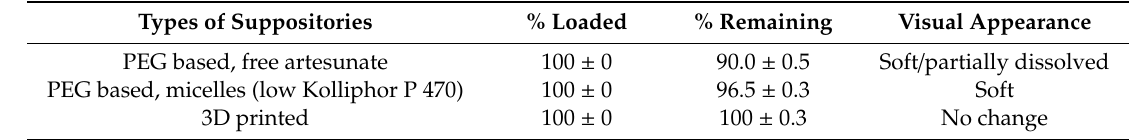
Table 5. Thermostability at 30 ◦ C (RH 35%) for 6